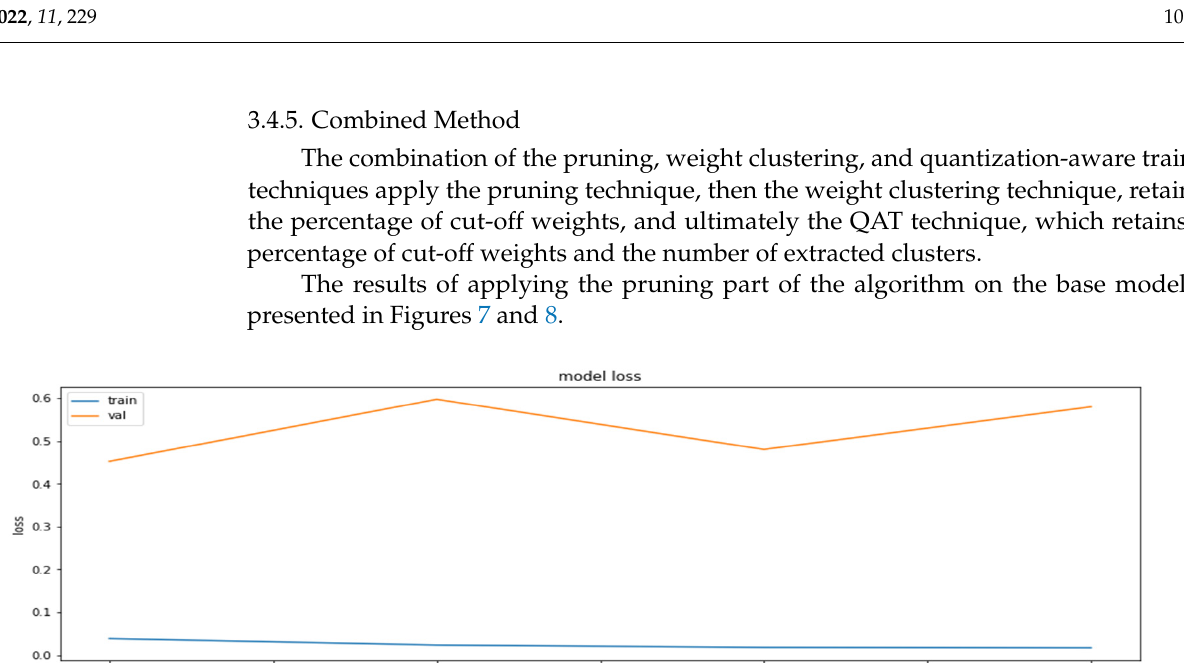
Figure 9. Training and the validation datasets obtained during the implementation of the weight clustering of the PCQAT.